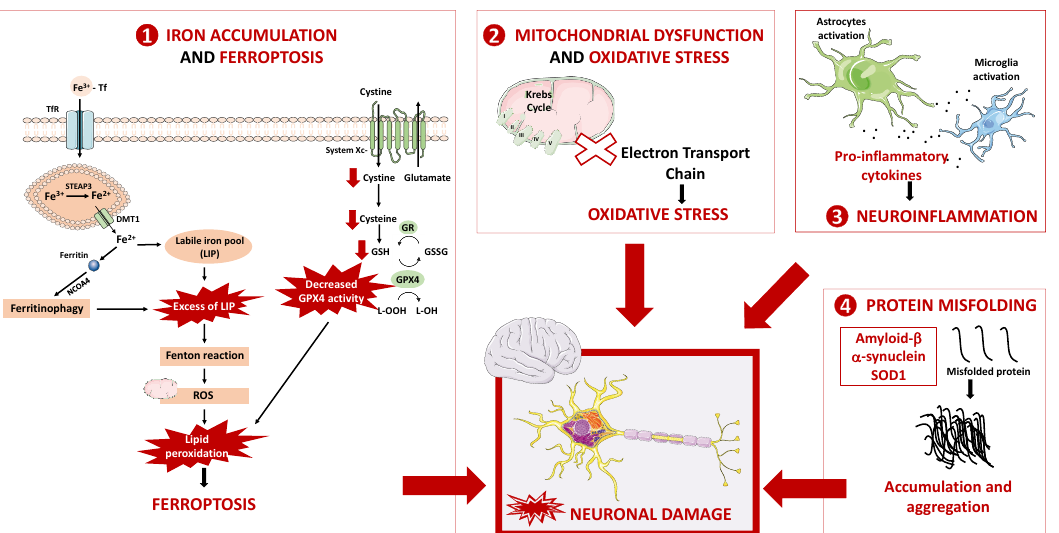
Figure 1. Common pathophysiological mechanisms underlying the most prevalent and debilitating neurodegenerative diseases. Neurodegenerative diseases are a group of debilitant conditions that result from the progressive damage inflicted to the neuronal cells and nervous system, with abnor- mal deposition of proteins, and with the progressive loss of synapses and neurons. Alzheimer’s disease, Parkinson’s disease, Amyotrophic Lateral Sclerosis, and Multiple Sclerosis are examples of complex neurodegenerative diseases sharing several common pathophysiological mechanisms, such as: (1) iron overload, (2) mitochondrial dysfunction and oxidative stress, (3) neuroinflamma- tion, and (4) protein misfolding. Iron has essential functions in the brain and, therefore, needs to cross the blood–brain barrier (BBB) to reach this organ. The most elucidating hypothesis of the pas- sage of iron through the luminal membrane of the capillary endothelium mainly occurs through the transferrin/transferrin receptor (Tf/TfR) pathway. This process starts with the binding of the com- plex ferric iron (Fe 3+ )-Tf to the extracellular portion of transferrin receptor (TfR), followed by the endocytosis of the complex, formation of endosome, and acidification of the microenvironment within endosome. Next, occurs the dissociation of iron from Tf and the reduction of ferric iron (Fe 3+ ) to Fe 2+ by the ferrireductase six-transmembrane epithelial antigen of prostate 3 (STEAP3). Fe 2+ accu- mulates in cytoplasm, forming the labile iron pool (LIP), and the excess of intracellular iron is then stored in ferritin. Ferritinophagy is defined as the autophagic degradation of ferritin, a process me- diated by nuclear receptor coactivator 4 (NCOA4). Ferritin, in combination with NCOA4, is trans- ported to the lysosomes for degradation, being then the iron released for cellular physiological ac- tivities. However, when this metal is in excess, it participates in Fenton reaction leading to a cycle between the two redox states and prompting the generation of •OH, promoting lipid peroxidation and ferroptosis, a new type of regulated cell death. Ferroptosis is also characterized by an inhibition of System Xc-, with the consequent decrease in glutathione peroxidase 4 (GPX4) activity and pro- motion of lipid peroxidation, leading to neuronal damage. Mitochondria are essential organelles for eukaryotic life, producing most of the energy or adenosine triphosphate (ATP) required by the cell, being responsible for cellular respiration and oxidative phosphorylation. Changes in the correct functioning or in structures involved in this process lead to a decrease in ATP production, to the accumulation of reactive oxygen species (ROS), and to the release of apoptosis-inducing factors, leading to oxidative stress and cell death. Neuroinflammation is another pathological mechanism present in neurodegenerative diseases, and results from the presence of chronically activated glial cells (astrocytes and microglia) in the brain, which release cytokines and chemokines that are toxic